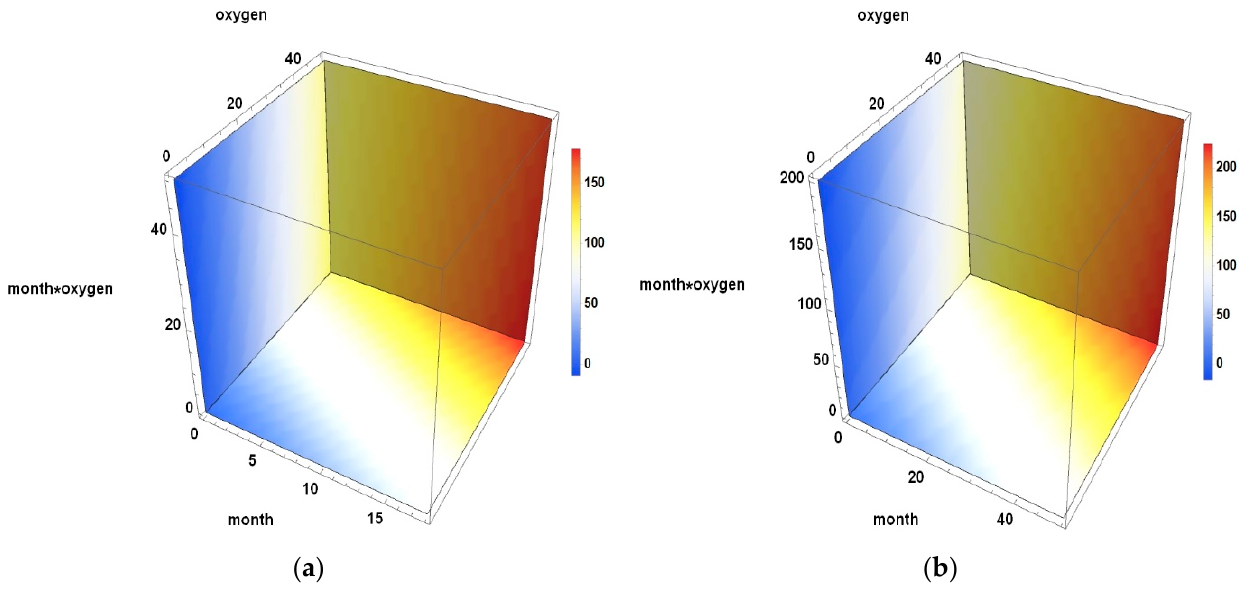
Figure 7. Predicted values of the corrosion depth obtained on the basis of regression models formed for the behaviour of the alloy under the influence of air on NiTi1 ( a ) and NiTi2 alloy ( b ).